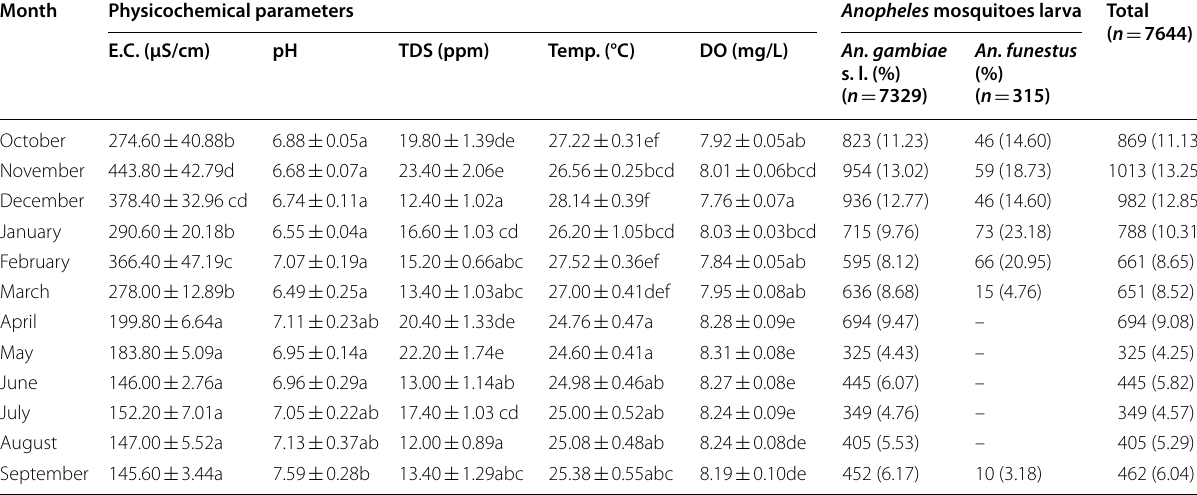
Means followed by the same alphabet (lower case) in column are not significantly different ( P > 0.05) from one another using Duncan’s new multiple range test (DNMRT)